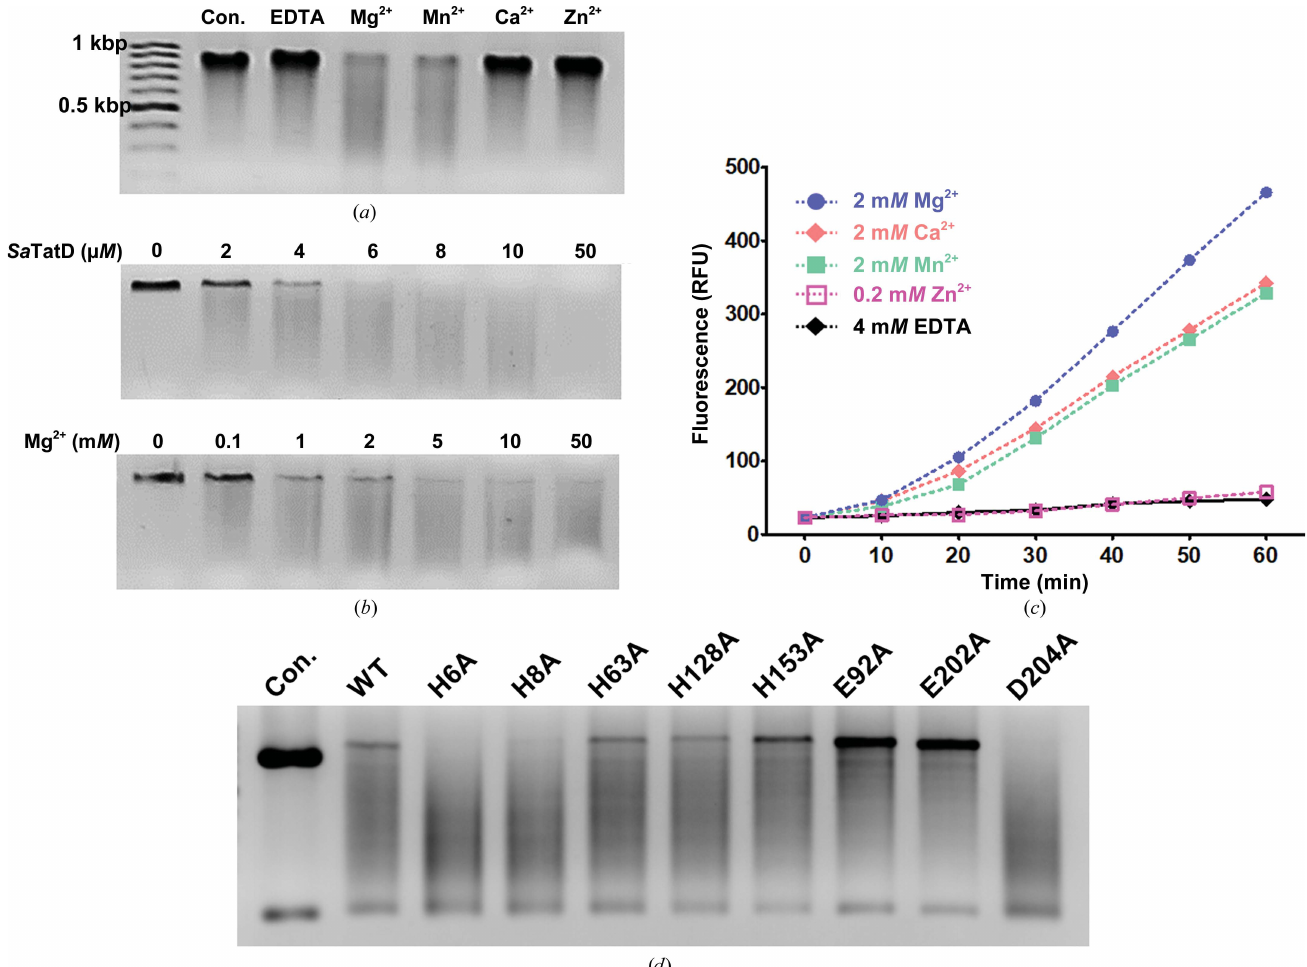
Figure 5 Nuclease activity assay of Sa TatD. ( a ) A metal-dependent DNase assay performed with 10 m M protein and 4 m M EDTA or 2 m M bivalent metals with 200 n M Sa TatD genomic DNA (771 bp) as a substrate for 1 h at 37 (cid:2) C. Control groups (Con.) were prepared without Sa TatD protein. ( b ) Protein or metal concentration-dependent DNase assay carried out with 2 m M Mg 2+ or 4 m M protein, respectively, in the presence of 100 n M substrate for 1 h at 37 (cid:2) C. ( c ) Metal-dependent RNase assay. Fluorescence values (relative fluorescence units; RFU) were measured at Ex/Em = 490/520 nm for 1 h at 37 (cid:2) C. ( d ) DNase activity assay for the mutational study of Sa TatD carried out with each mutant protein at 4 m M , 2 m M Mg 2+ , 200 n M Sa TatD genomic DNA for 1 h at 37 (cid:2)